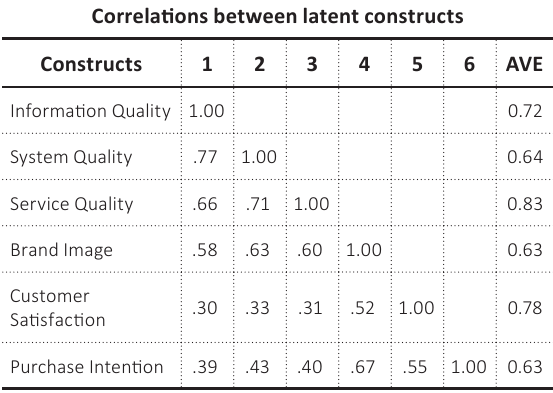
Table 2. Composite variable – construct correlations and average variance extracted (AVE)